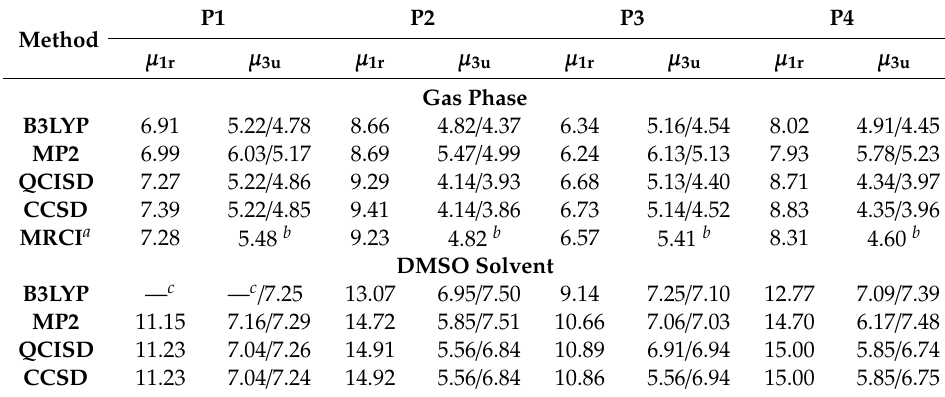
Table 4. Dipole moments ( µ ), in Debye (D), for singlet ( µ 1r ) and triplet ( µ 3u ) wave functions (rigid / relaxed), with aug-cc-pVDZ basis set in gas phase and DMSO solvent.